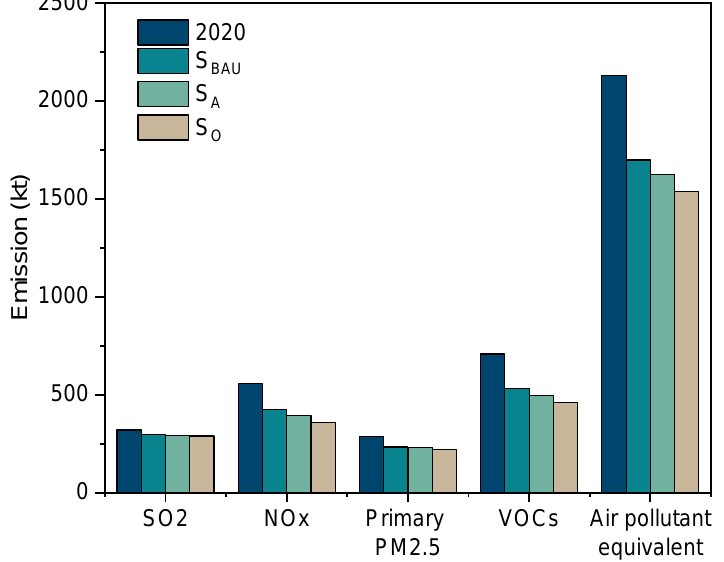
Figure 3. Emission reduction benefits from different scenarios in 2025 compared to 2020. Figure 4 denotes that clean air measures such as industrial end-of-pipe measures, energy structure adjustment, industrial structure adjustment, transportation structure adjustment and retiring yellow-label and old vehicles show great reduction benefits among the three scenarios. The emission reduction share rates of energy structure adjustment (M2), industrial structure adjustment (M3), transportation structure adjustment (M6), industrial end-of-pipe measures (M1), retiring yellow-label and old vehicles (M4) and promoting new energy vehicles (M5) account for 13.7%, 8.7%, 4.3%, 44.9%, 23.8% and 4.5% under S BUA , 13.3%, 8.7%, 4.3%, 44.8%, 24.5% and 4.4% for S A , and 12.8%, 8.2%, 5.1%, 44%, 25.5% and 4.4% for S O , respectively.